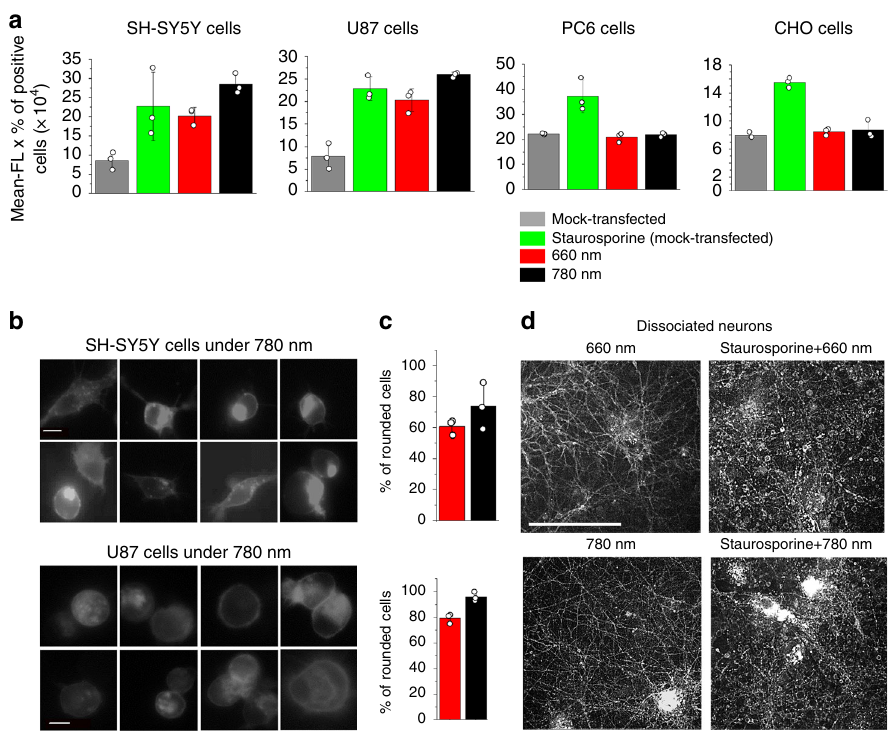
Fig. 7 Regulation of apoptosis in neuroblastoma and glioblastoma by Dr-TrkA. a SH-S5Y5, U87, PC6-3, and CHO cells were co-transfected in 48-well plate with 250 ng mixture of the pCMVd2-mCherry-Dr-TrkA and pcDNA3.1 plasmids in the 1:1 mass ratio. The transfected cells were illuminated with either 660 nm or 780 nm light for 6 h, stained with annexin V, and analyzed using fl ow cytometry. As a positive control, cells transfected with pcDNA3.1 only (mock-transfected cells) were treated with 100 nM staurosporine. b Epi fl uorescence images of SH-SY5Y and U87 cells transfected with mCherry-Dr-TrkA illuminated with near-infrared (NIR) light, Scale bar, 10 μ m. c Quanti fi cation of the rounded cells under either 660 nm or 780 nm light. Error bars represent s.d., n = 3 experiments. d Epi fl uorescence images of cultured rat cortical neurons transduced with adeno-associated virus serotype 9 (AAV9) encoding mCherry-Dr-TrkA. At 24 h after the transduction, neurons were illuminated for 6 h with either 660 nm or 780 nm light. As a positive control, the transduced neurons were treated with 100 nM staurosporine for 6 h. Scale bar, 100 μ m. Error bars represent s.d., n = 3